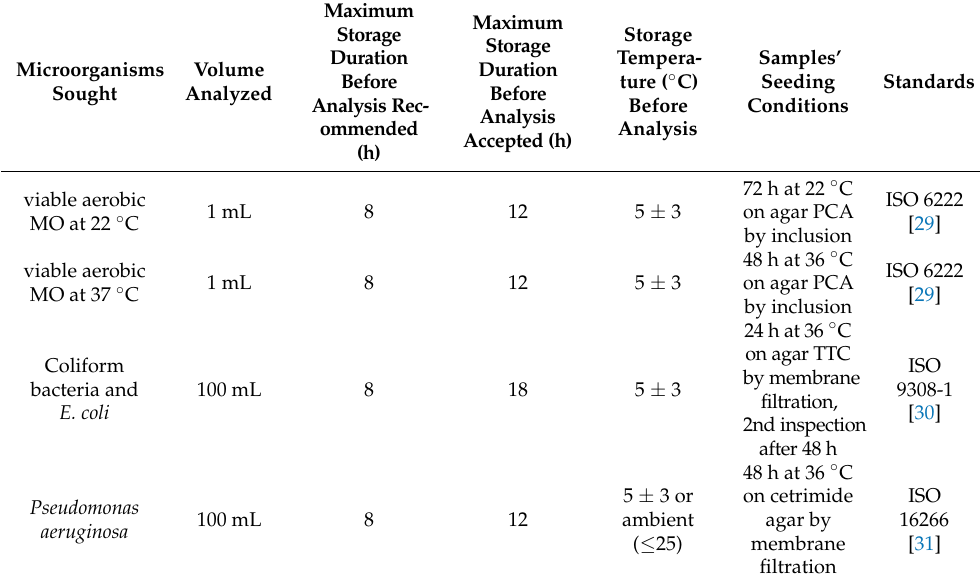
Table 1. Culture conditions of the output water samples collected from the dental units and standards